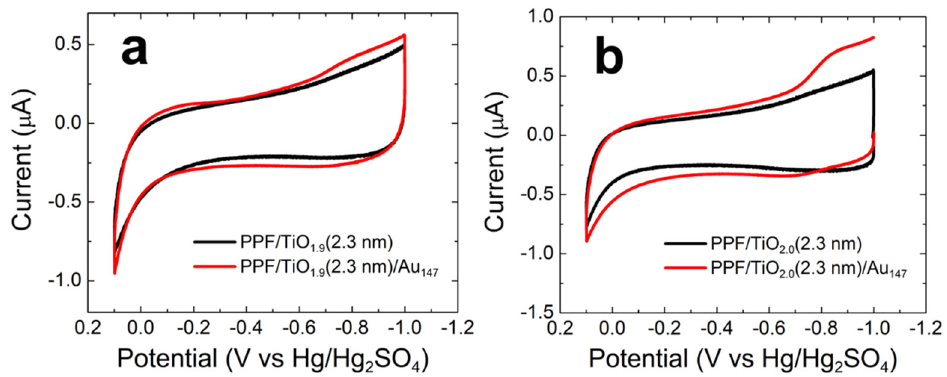
Figure 2. CVs obtained for CO electrooxidation on ( a ) PPF/TiO 1.9 (2.3 nm)/Au 147 and ( b ) PPF/TiO 2.0 (2.3 nm)/Au 147 electrodes. The specific electrode configurations are given in the legends. The solutions contained aqueous, CO-saturated 0.10 M NaOH. The electrode potential was scanned between −1.0 and 0.10 V at 0.050 V/s. The experiments were carried out in triplicate for each electrode configuration using independently prepared electrodes to ensure reproducibility.